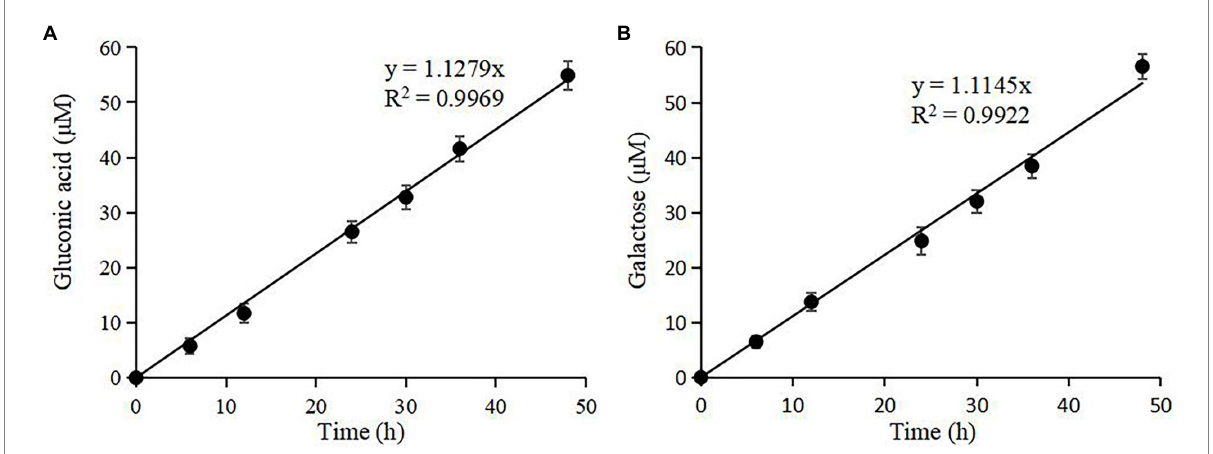
FIGURE 7 Quantification of rTaAA9A reaction products by HPLC-RID analysis. (A) TFA hydrolyzed the reaction products of rTaAA9A; then, gluconic acid was quantified with HPLC-RID analysis. (B) The reaction products of rTaAA9A were reduced by NaBH 4 followed by hydrolysis with TFA, and then galactose was quantified using HPLC-RID. All experiments were performed in three replicates, and error bars indicate the standard